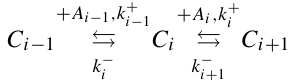
Figure 8. Average hydration numbers per cluster for various (cid:113) SA base clusters at